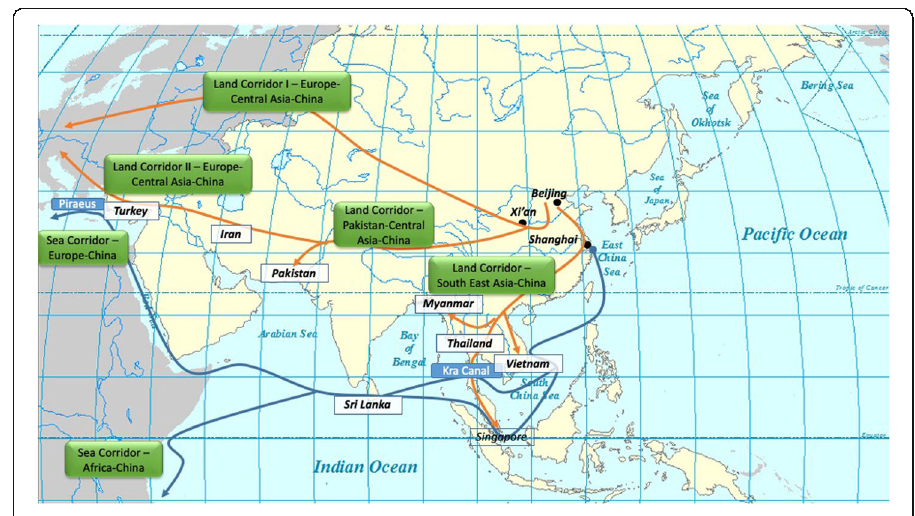
Fig. 3 BRI corridors (Source: Ferrari et al. 2018)